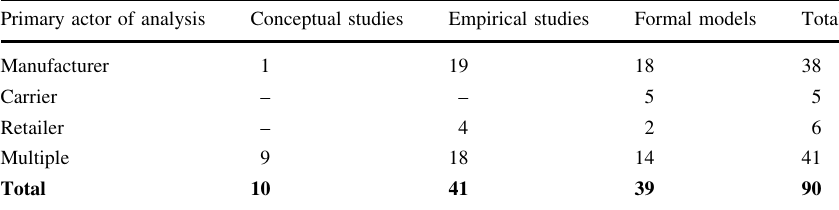
Table 7 Primary actor of analysis Primary actor of analysis Conceptual